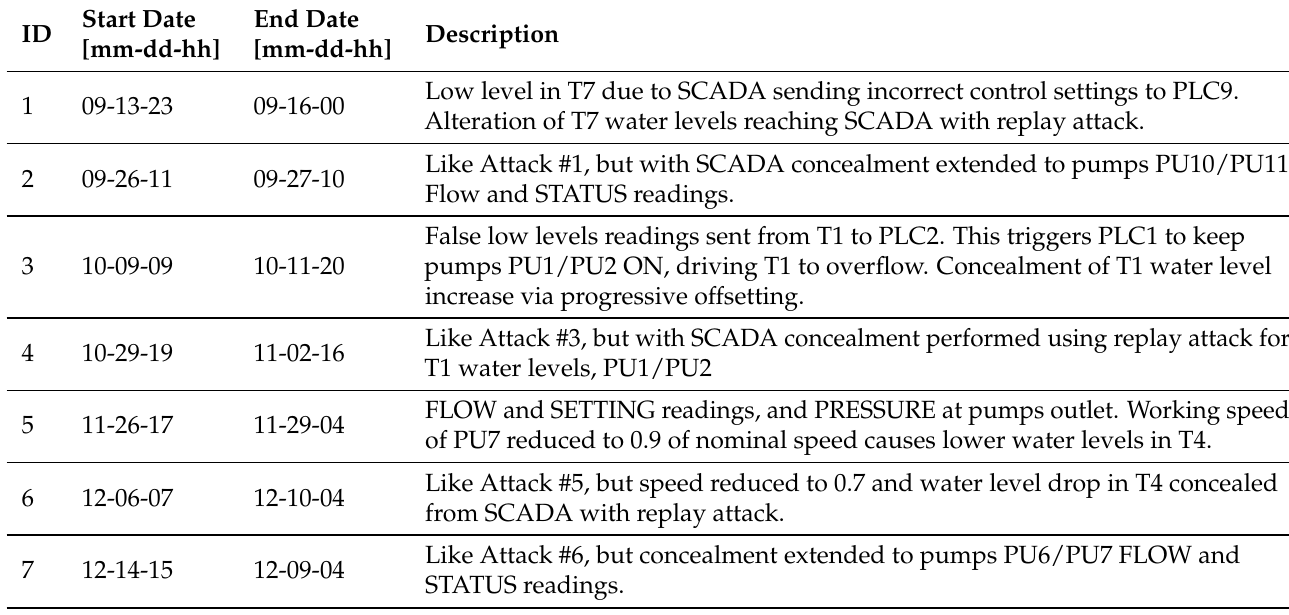
Table 2. Attack Scenarios [27]. (Reproduced with permission from the data availability